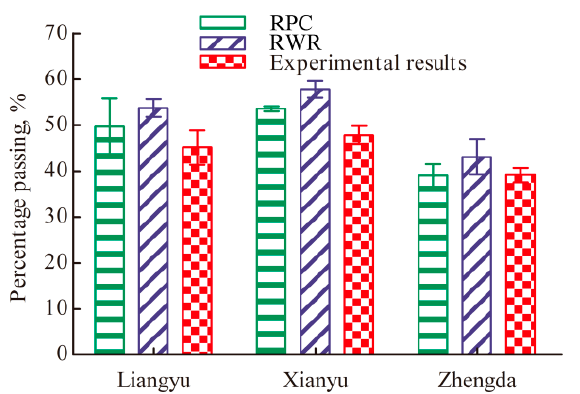
Figure 17. Comparisons between the experimental results and the simulation results in terms of total percentages passing for three varieties.